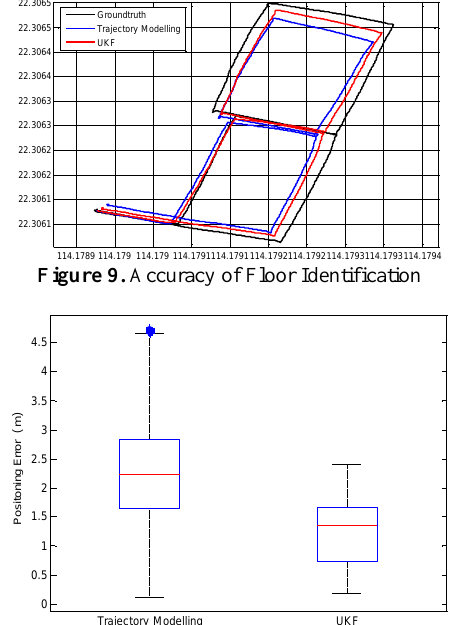
Figure 6. Detection Error of Wi-Fi APs